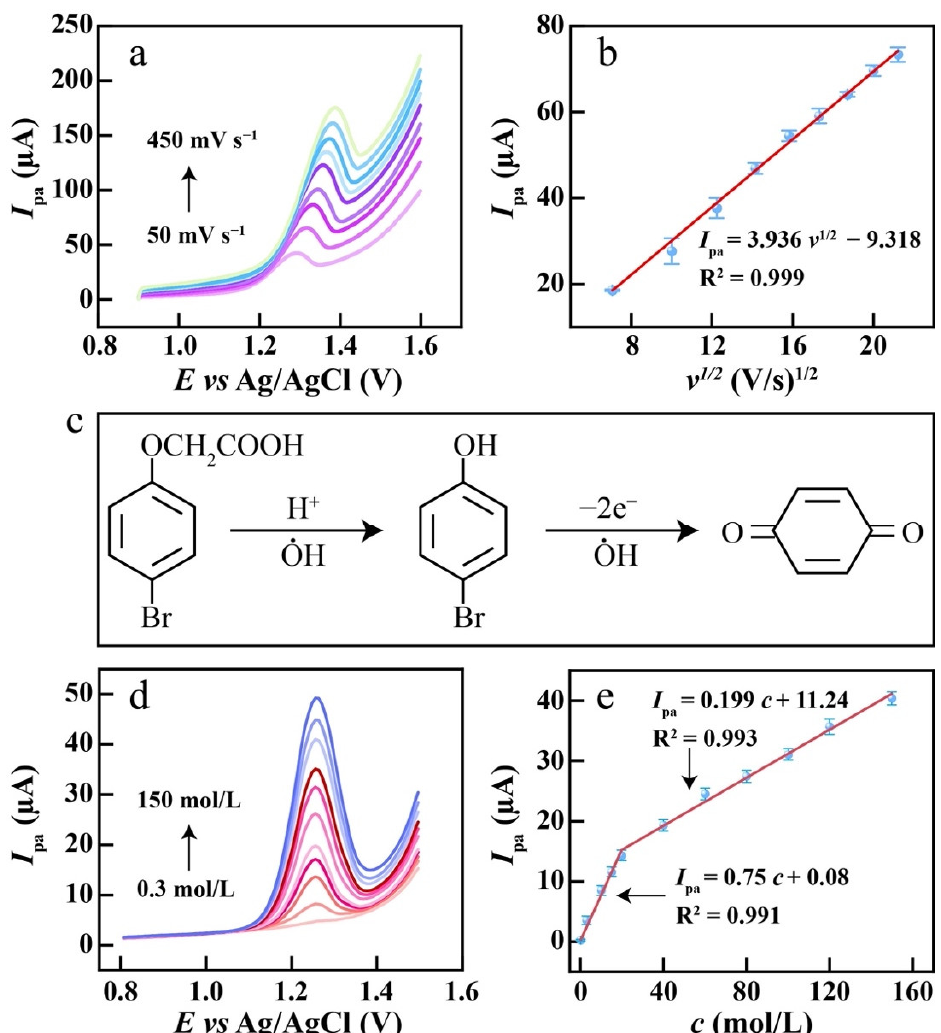
Figure 5. ( a ) LSVs of CeO 2 /eGr/GCE in 0.1 M PBS solution containing 20 μmol L −1 4-BPA at 50, 100, 150, 200, 250, 300, 350, 400, 450 mV s −1 , ( b ) the plot of I pa vs. v 1/2 , ( c ) the proposed electrochemical reaction process of 4-BPA, ( d ) DPVs of CeO 2 /eGr/GCE in 0.1 M PBS solution containing 0.3, 3, 10, 15, 20, 40, 60, 80, 100, 120, 150 μmol L −1 4-BPA, ( e ) the plot of the oxidation peak current vs. the concentration of 4-BPA.